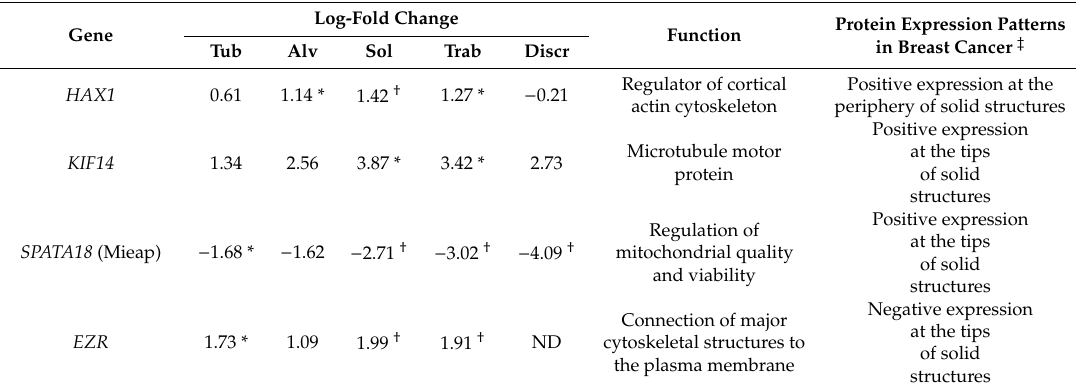
Table 1. Genesdifferentiallyexpressedinsolidandtrabecularstructuresandassociatedwithcellmigration.